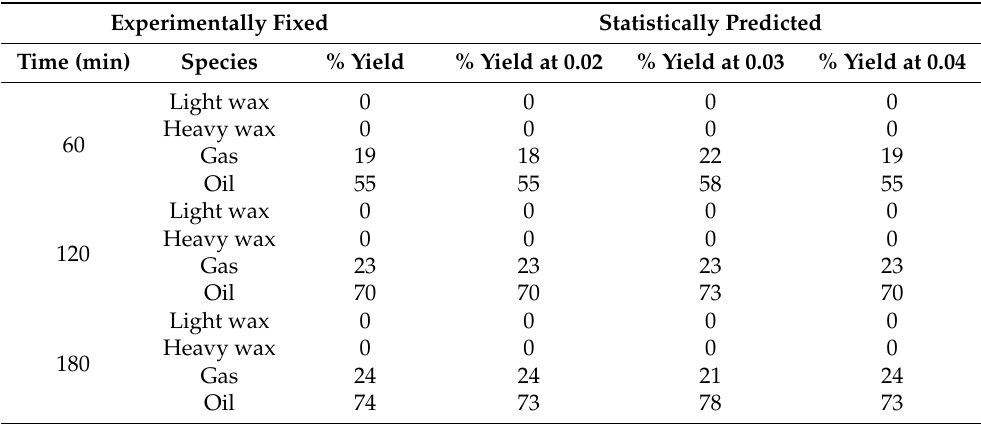
Table 8. Process time-dependent product yield produced with experimentally fixed and statistically predicted rate constants.